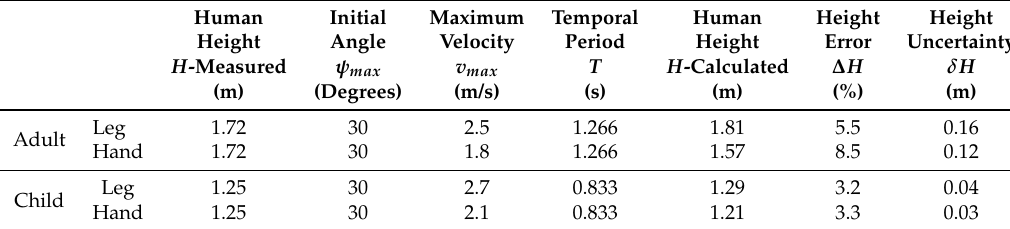
Figure 8. Velocity of the right hand and leg: ( a ) Obtained by video frames. ( b ) Obtained by micro-Doppler radar. ( c ) Comparison between the two methods. Table 2. Results of adult and child height estimation obtained from the human motion